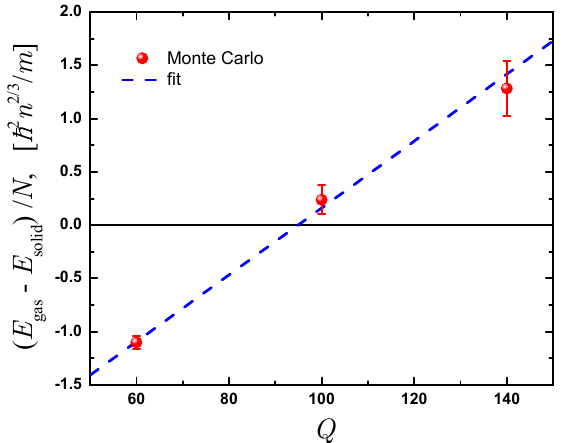
Figure 2. The difference of the energy per particle between the gas and solid phases as a function of Q . Symbols report Monte Carlo data, line shows the linear fit. The point where the difference is equal to zero corresponds to the location of the phase